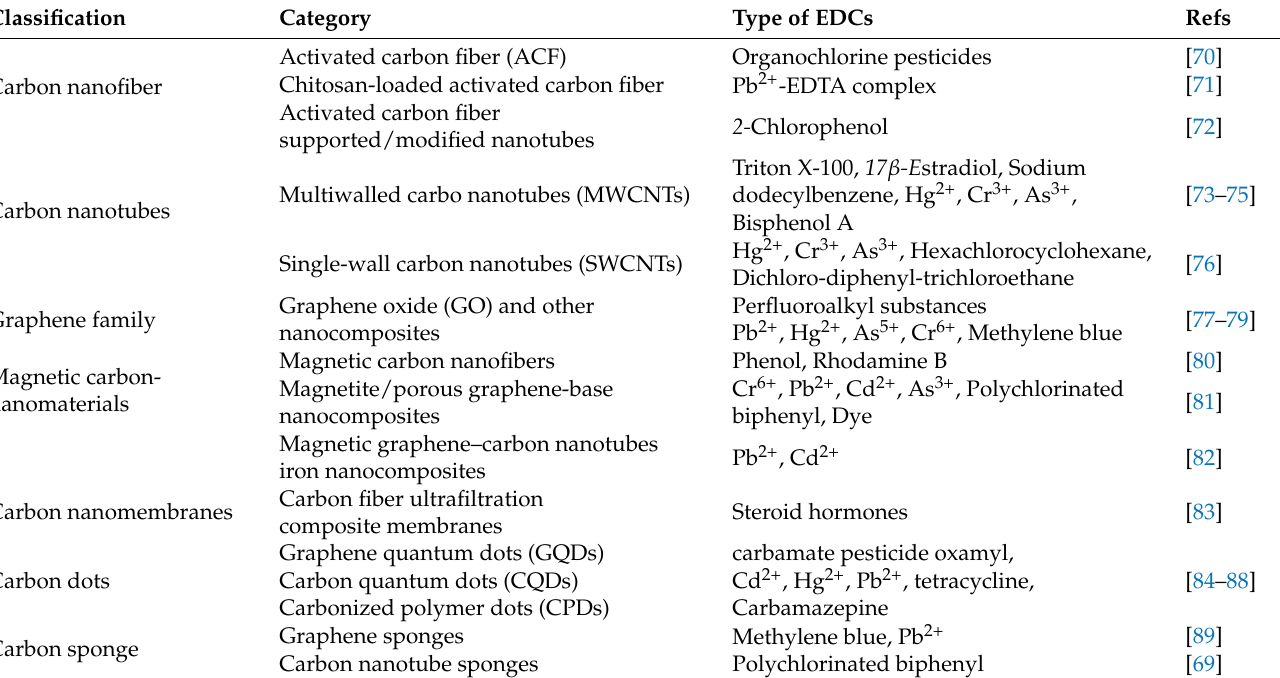
Figure 2. Schematic diagram of carbon nanoadsorbents for EDC adsorption for wastewater treatment, the categories of carbon nanoadsorbents, and nanoadsorbents in applications for the decontamination of wastewater. Table 2. Different categories of carbon